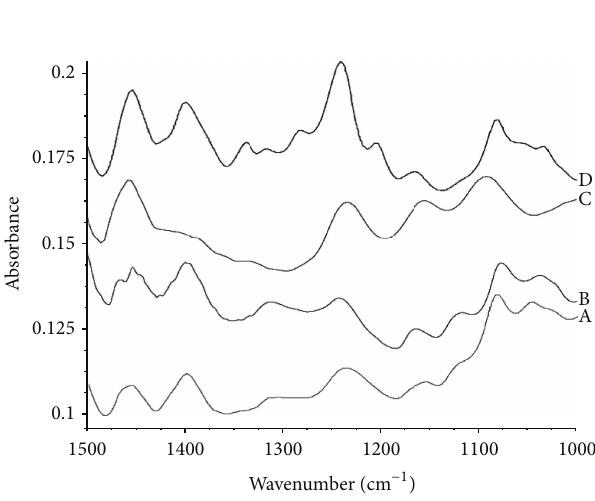
Figure 3: FTIR spectra of four samples from Parts A, B, C, and D, with wavenumber ranging from 1500 cm −1 to 1000cm −1